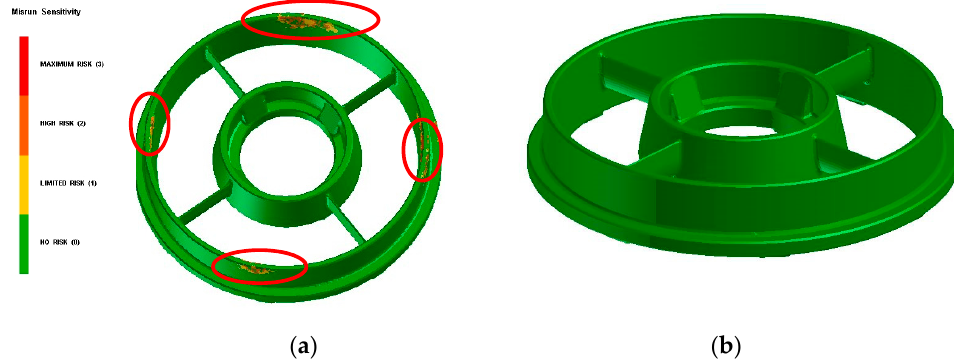
Figure 5. Misrun risk prediction results of 4 × ( a ) and 8 × ( b ) gravity gating systems. In ( a ) misrun risk was seen in the 4 × cross runner while misrun risk was not seen in the 8 × cross runner.